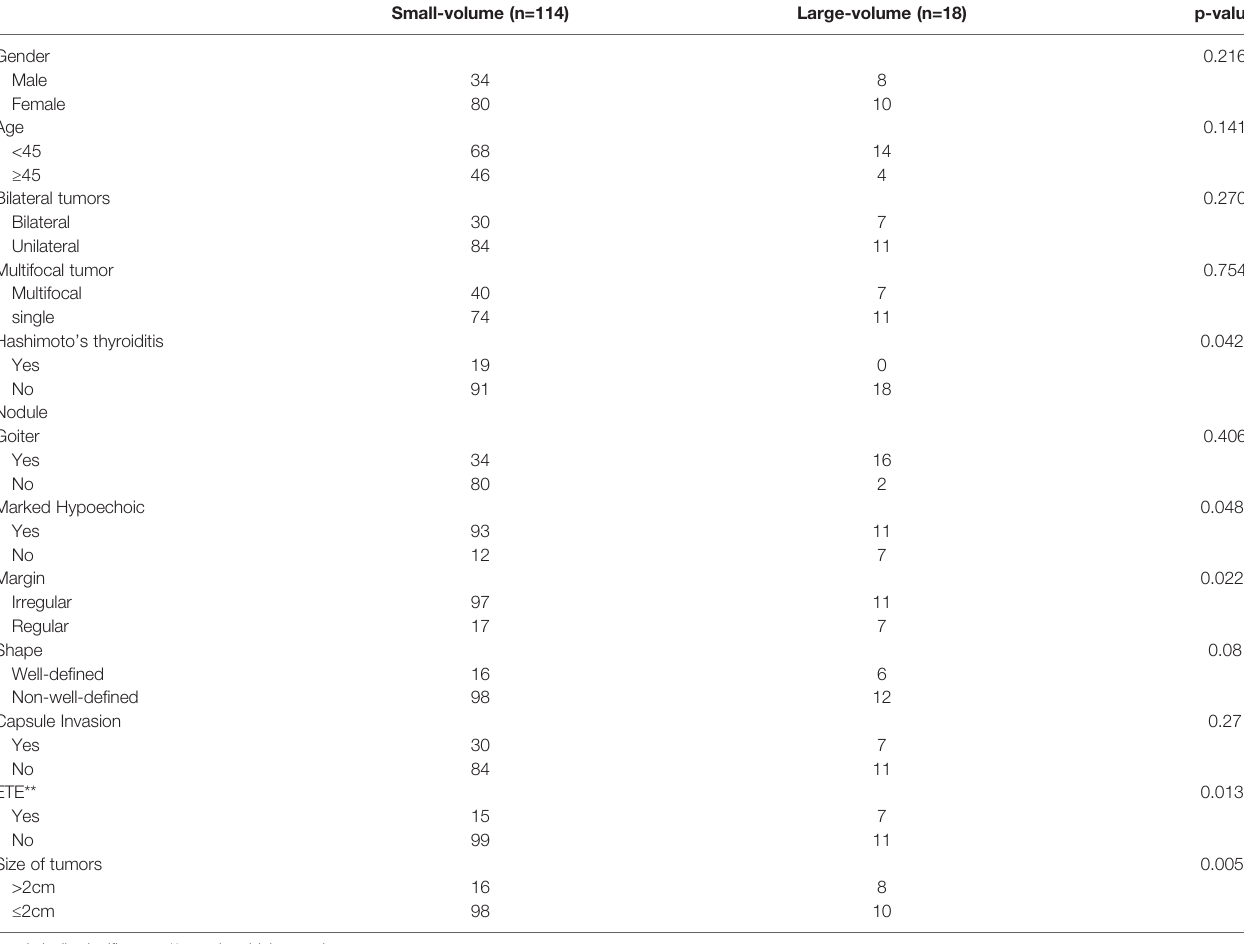
TABLE 5 | Clinicopathological characteristics and univariate analysis of CPTC patients